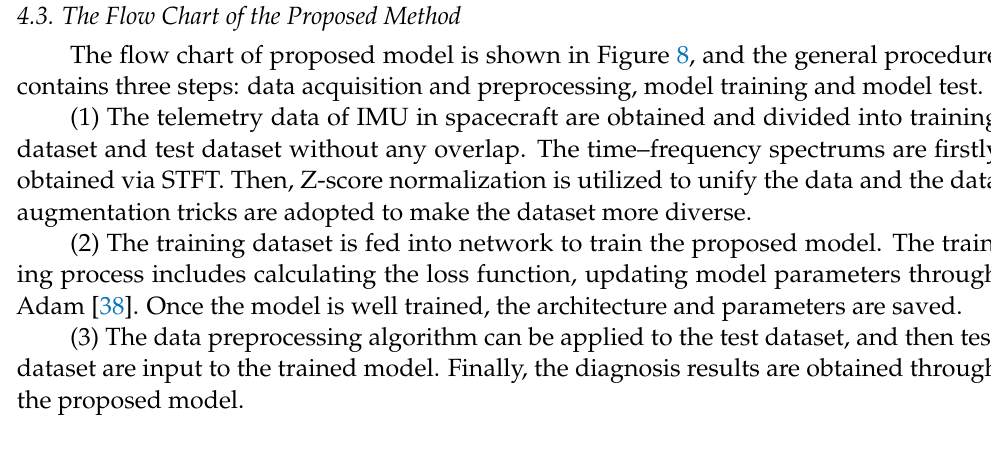
Figure 7. The overall structure of proposed neural